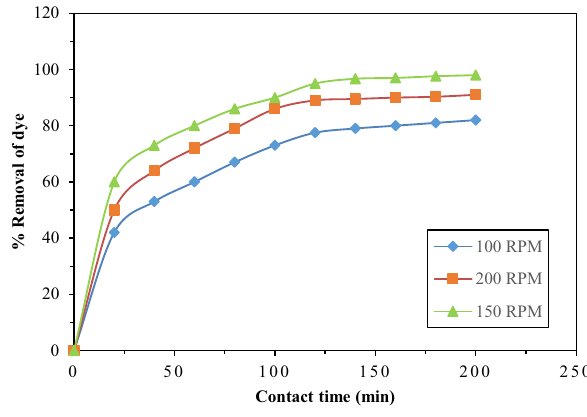
Fig. 7 Influence of initial MR dye concentration onto removal capac-